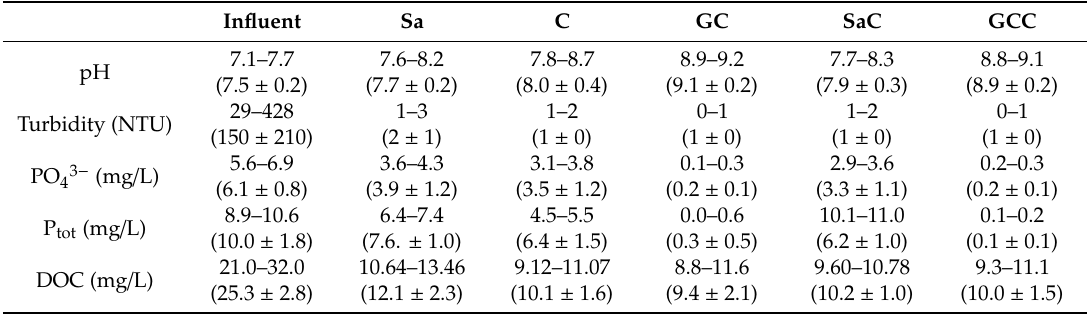
Table 2. Confidence and mean values (with standard deviation) of observed